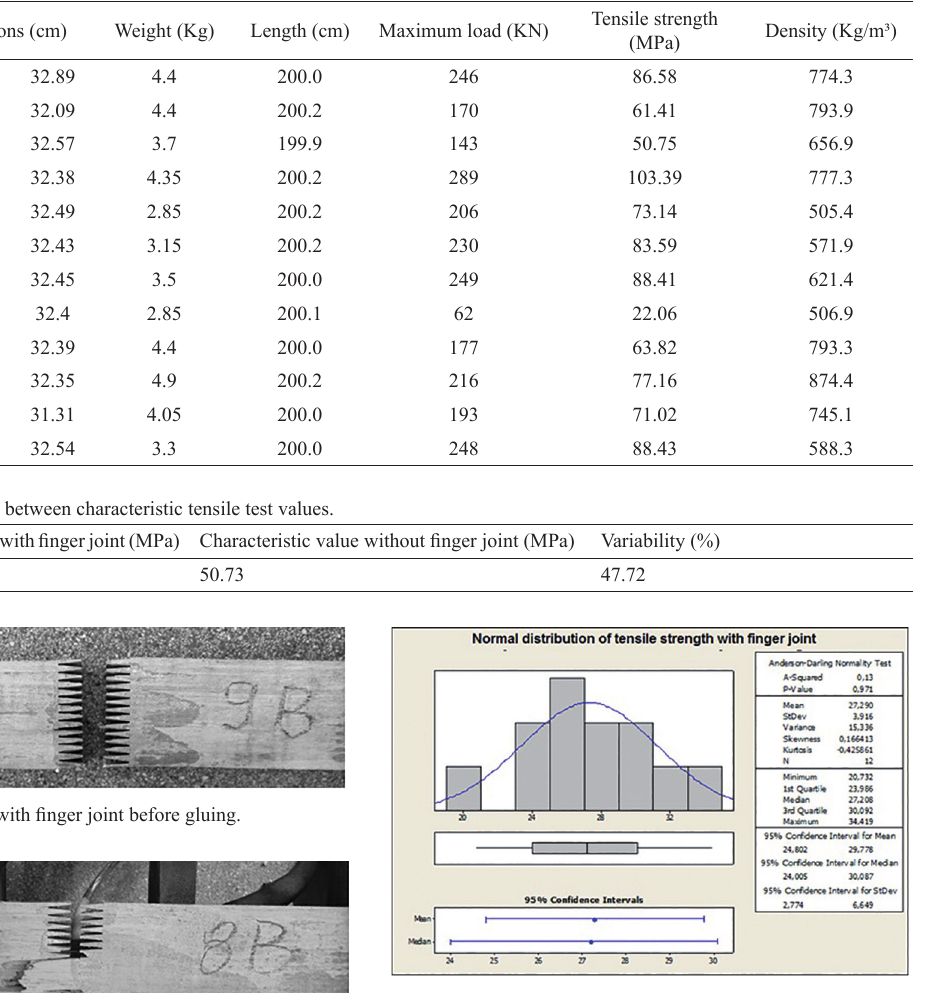
Figure 7: Histogram showing tensile strength values for samples with finger joints.